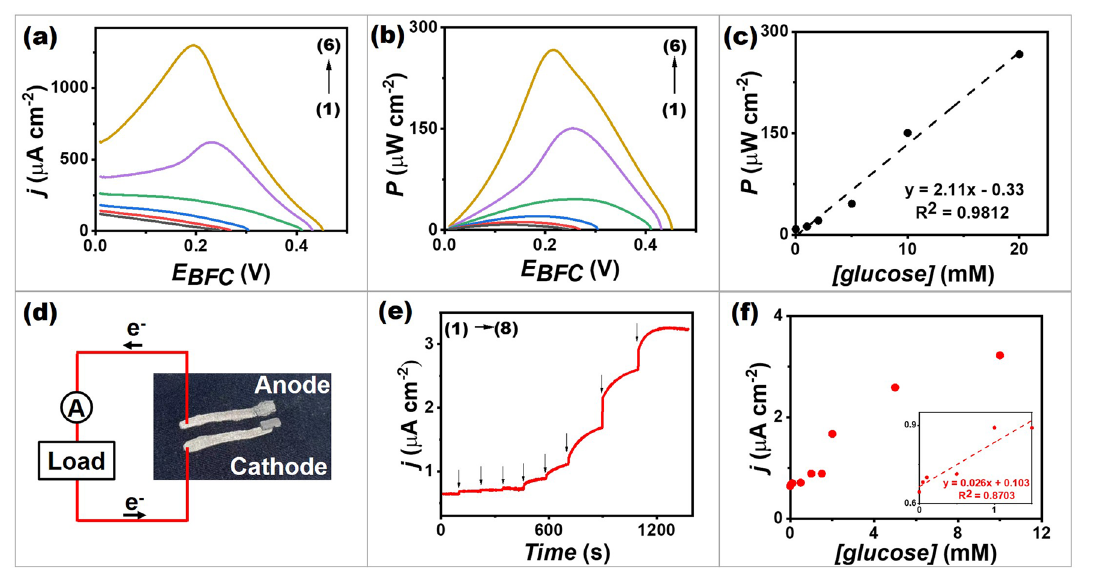
Fig. 4 A BFC and a self-powered glucose biosensor. a Polarization curves of a screen-printed glucose BFC at different glucose concentra- tions ((1) blank; (2) 1 mM; (3) 2 mM; (4) 5 mM; (5) 10 mM; and (6) 20 mM) in 0.1 M PBS, pH 7.0. b Power density versus potential plots of a screen-printed glucose BFC at different glucose concentrations (1) blank; (2) 1 mM; (3) 2 mM; (4) 5 mM; (5) 10 mM; and (6) 20 mM) in 0.1 M PBS, pH 7.0. c The corresponding calibration plot of power and glucose concentrations. d Schematic illustration of the self-powered biosensing electronic system. e The self-generated current response obtained from a screen-printed glucose BFC, with no applied potential upon increasing the glucose concentrations (0, 0.05, 0.1, 0.5, 1, 1.5, 2, 5 and 10 mM) in 0.1 M PBS, pH 7.0. The current was observed at a constant load between electrodes of 99.7 kΩ. f The corresponding calibration plot of the current response and glucose concentrations of a screen-printed glucose